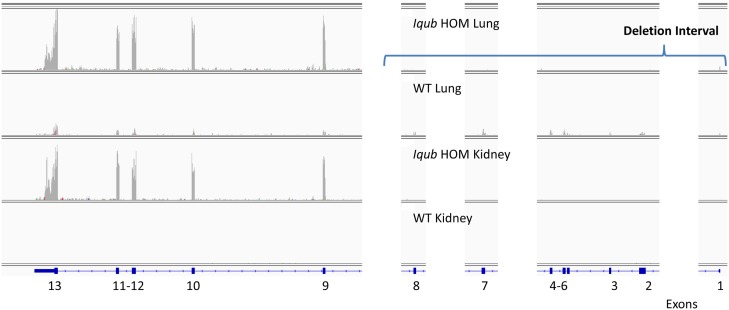
Reads for Iqub DEL HOM mutant and WT lung and kidney libraries mapping to Iqub genomic sequence.The Iqub gene is expressed at low levels in WT lung, and is not expressed in WT kidney. The expression in Iqub DEL HOM mutant lung and kidney is significantly increased compared with WT, but only for exons 9–13. This is consistent with targeting deletion of only exons 1–8 in the DEL mutant, and overexpression of the remaining exons in the mutant.